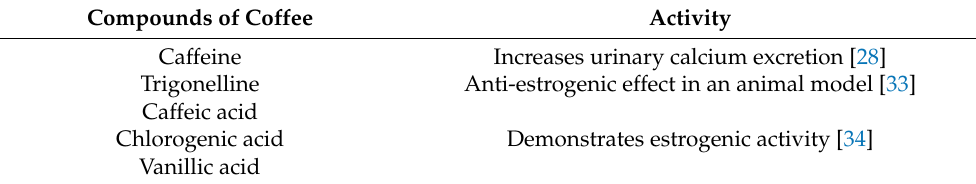
Table 1. Impact of coffee compounds on the